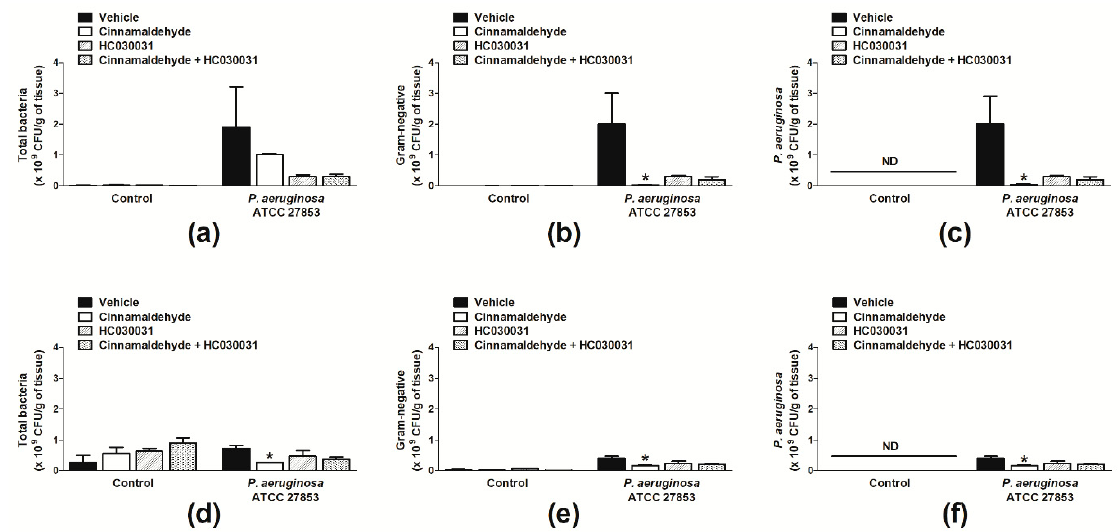
Figure 2. Effects of topical cinnamaldehyde or systemic TRPA1 antagonism on skin wound bacterial population. Total bacteria ( a ), Gram-negative bacteria ( b ) and P. aeruginosa ( c ) population in skin wound samples of infected and non-infected mice on day 4 post-skin excision. Total bacteria ( d ), Gram-negative bacteria ( e ) and P. aeruginosa ( f ) population in skin wound samples of infected